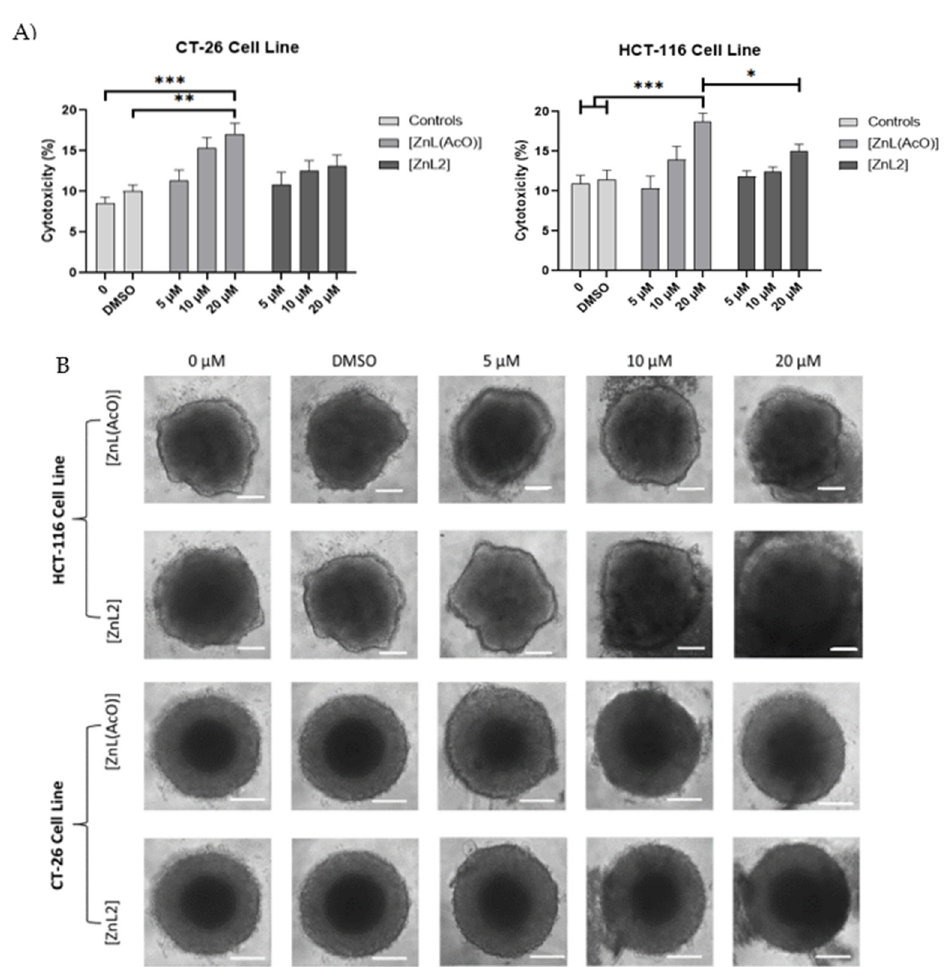
Figure 1. ( A ) Cytotoxicity effect of zinc complexes [ZnL(AcO)] and [ZnL 2 ] towards CT-26 and HCT-116 spheroids. Results correspond to cellular toxicity expressed as mean percentage (%) ± SD of three independent experiments with three replicates each after 72 h incubation with different metal-complex concentrations (5, 10, and 20 µ M) in their free forms (LDH assay) (* p < 0.05 vs. C8 at 20 µ M, ** p < 0.01, *** p < 0.001 vs. controls (0/ DMSO)). ( B ) Representative microscopic images of spheroids 72 h after incubation with the respective formulations. Scale bar = 100 µm.